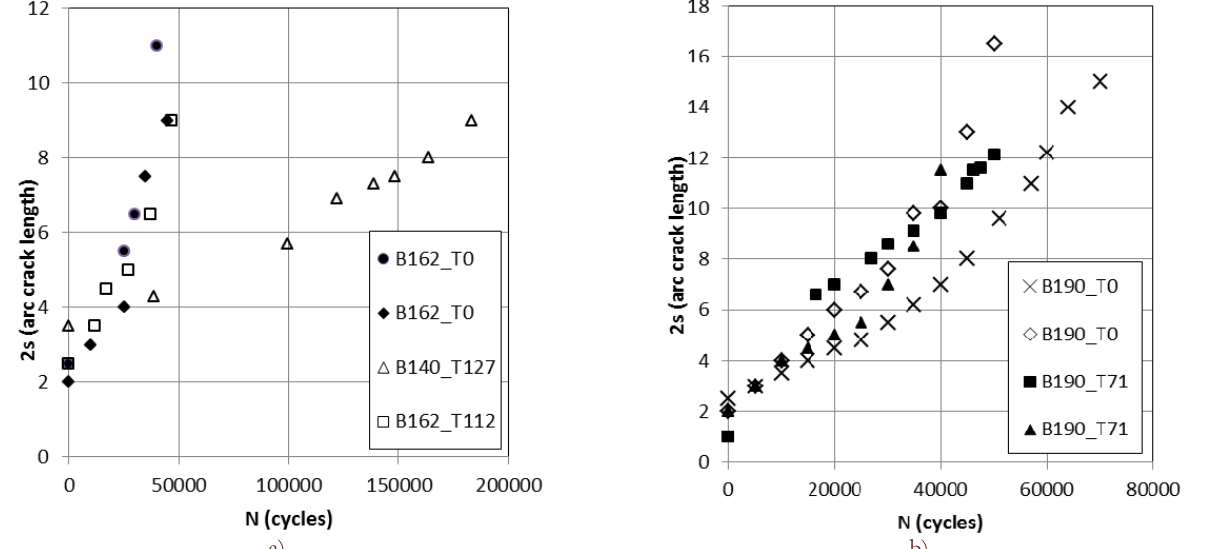
Figure 5: Arc crack length evolution with number of cycles: a) 10 mm specimen diameter; b) 12 mm specimen